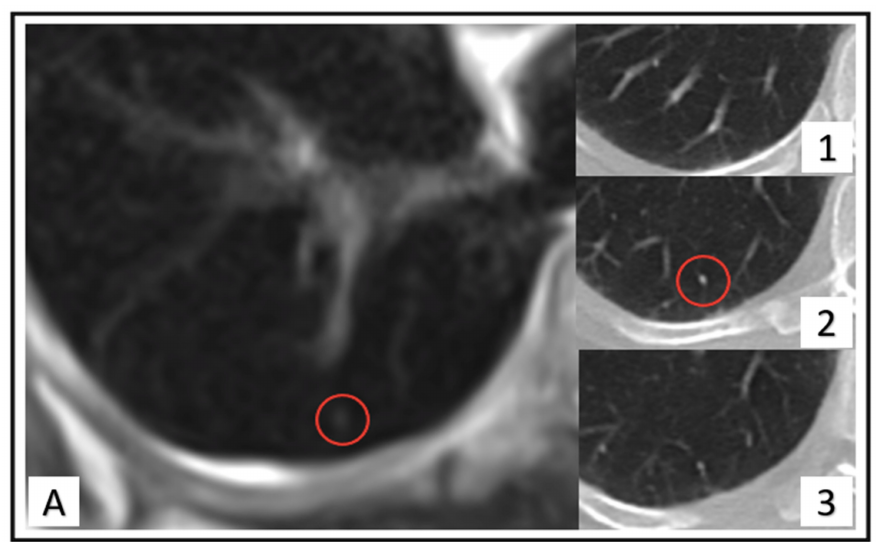
Figure 3. Images of a 62-year-old woman. Three-millimeter lung nodule located in right lower quad- rant (red circle) identified at HASTE sequence ( A ) that turned out as vessel in CT ( 1 – 3 ), continuous structure) due to slice-thickness artifact, evaluated as